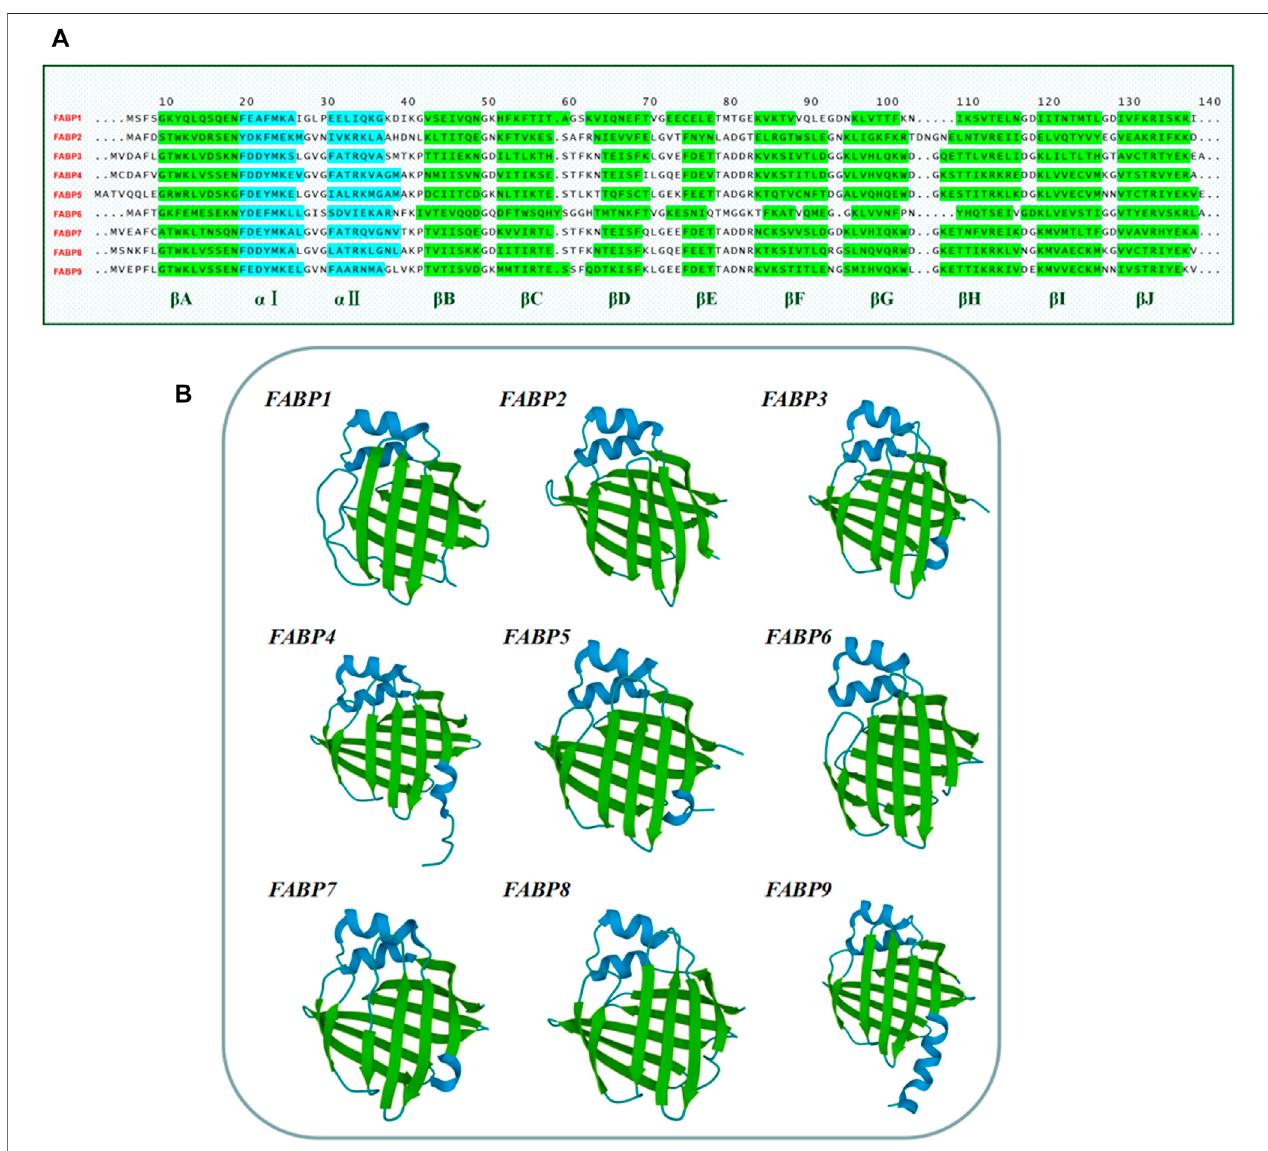
FIGURE 2 | Amino acid sequences and tertiary structure of the human FABP family members. (A) Amino acid sequences of the human FABPs. Amino acid sequences were obtained from the National Center for Biology Information (NCBI) website (www.ncbi.nlm.nih.gov/). (B) The tertiary structure of the human FABP family members 1 – 9. The structures were adjusted to a similar angle. The structures were obtained from RCSB PDB (Research Collaboration for Structural Bioinformatics, ProteinDataBank)(https://www.rcsb.org/structure/).FABP1(PDB code:1LFO), FABP2(PDB code:3IFB),FABP3 (PDBcode:4TKB),FABP4 (PDBcode:3P6D), FABP5 (PDB code: 4AZQ), FABP6 (PDB code: 5L8I), FABP7 (PDB code: 1FDQ), FABP8 (PDB code: 1PMP), FABP9 (PDB code: 4A60).